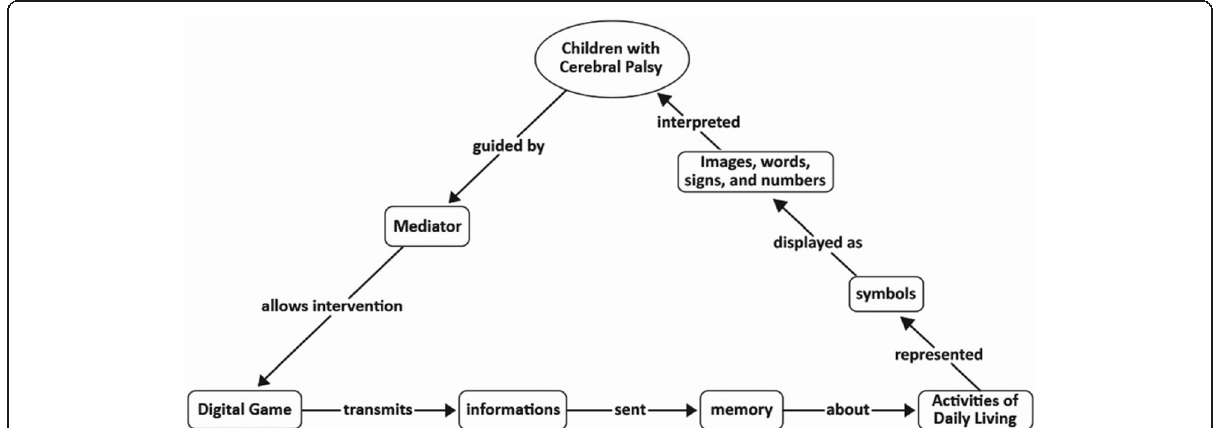
Fig. 1 Representation of the digital memory gaming concept in ADL. Source: Developed by the